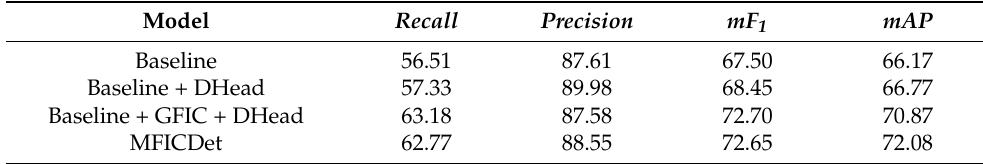
Table 2. Results of ablation experiments on the DIOR dataset.